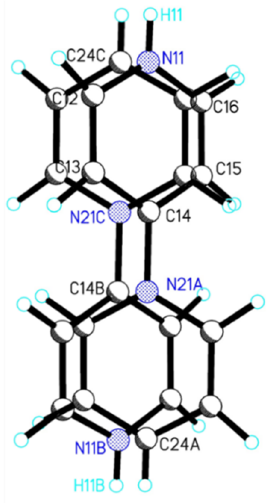
Table 2. Selected bond lengths (Å) and angles (°) in 1 and 2 . (Symm. Op. a = −x, y, ½ − z).